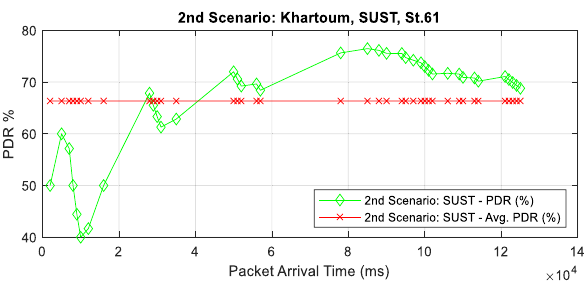
Fig. 7 PDR and received packets as a function of time (2nd scenario)